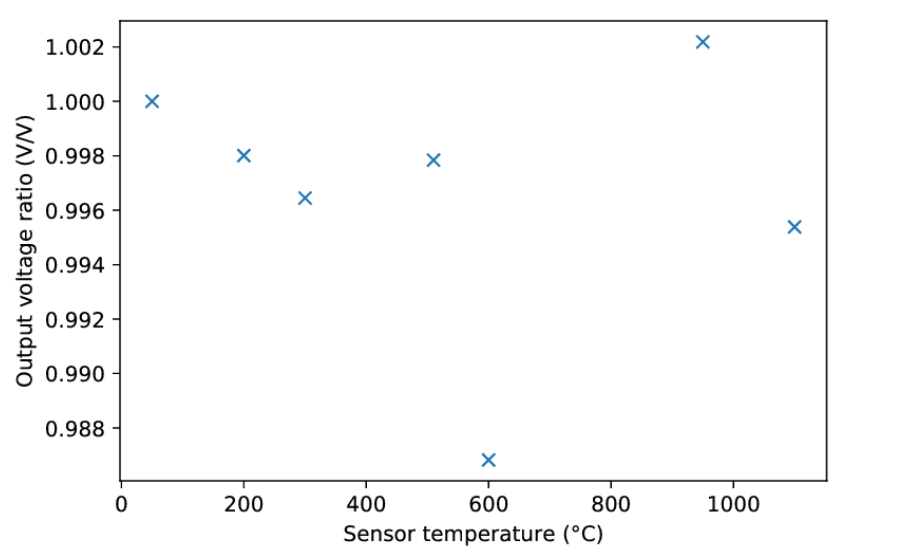
Figure 11. Hot sensor output voltage related to cold probe.